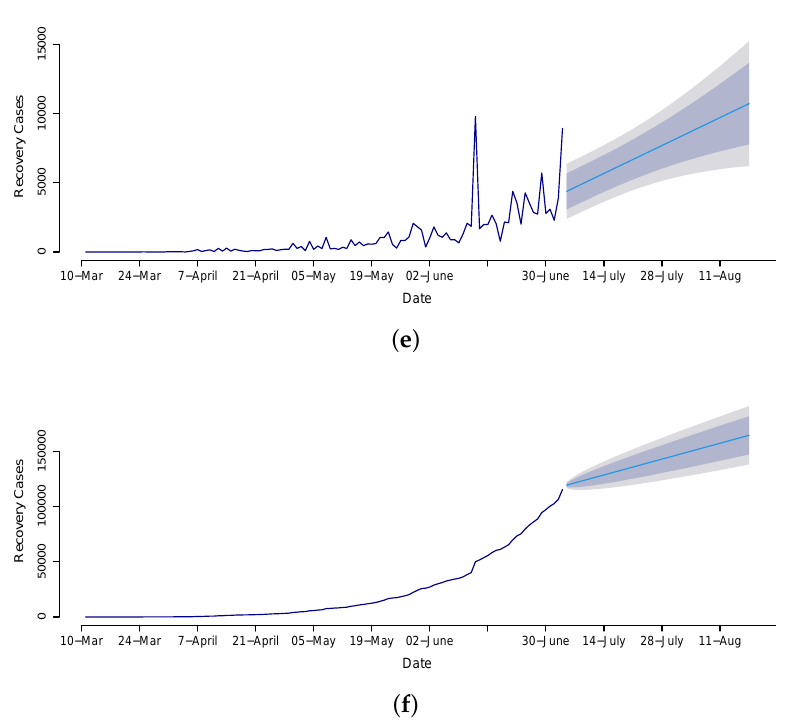
Figure 7. Forecasts for COVID-19: Confirmed daily and cumulative cases using the MA model ( a , b ), daily and cumulative deaths using the ANN model ( c , d ), and daily and cumulative recovered cases using the ANN model ( e , f ) for the period 3 July to 14 August